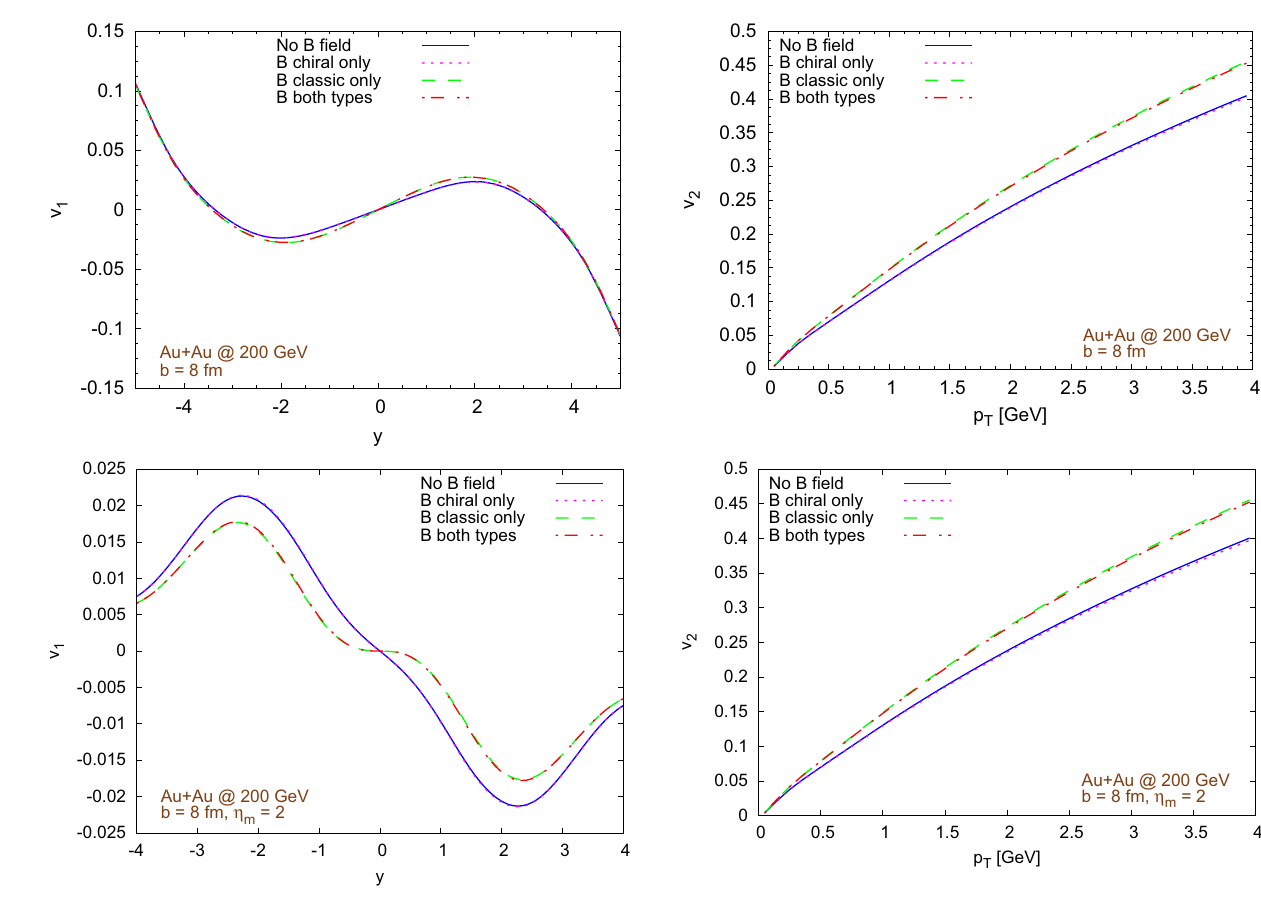
initial energy density profile tilting (see App. B). Bottom: Simulations with initial energy density distribution tilting ( η m = 2, see App.